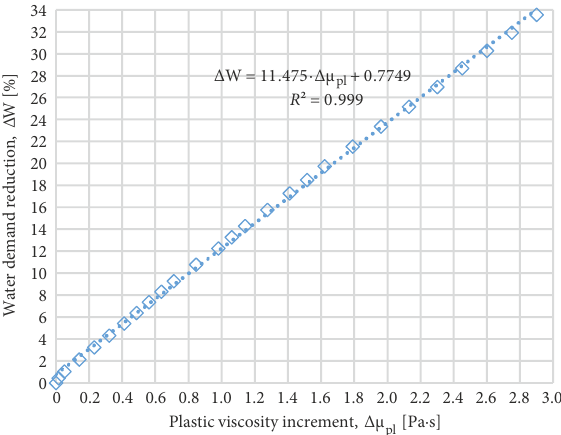
Figure 6. Dependence of reduction in the water demand on the increase of the plastic viscosity of the Portland cement paste